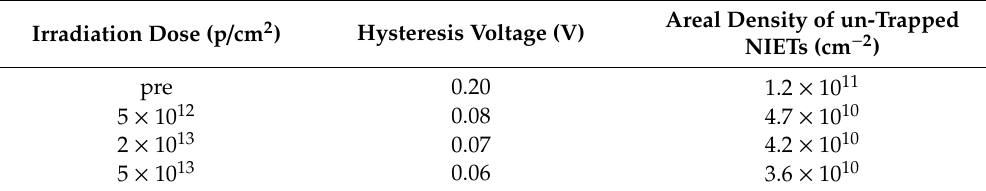
Figure 6. Bidirectional HF C-V characteristics of the samples irradiated by proton doses. Table 1. Extracted hysteresis voltage and the areal density of un-trapped NIETs of the samples irradiated by proton doses.